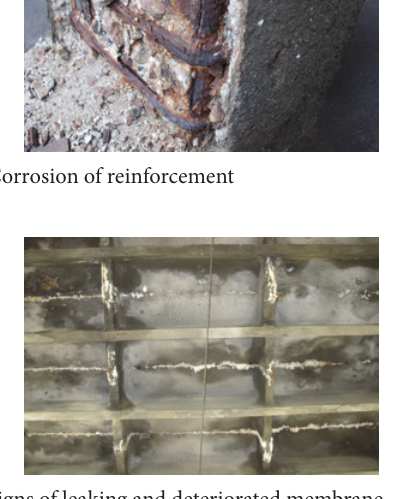
fig. 17. Locations of samples P3, P4 and P5 for bridge over the Daugava on bypass A5